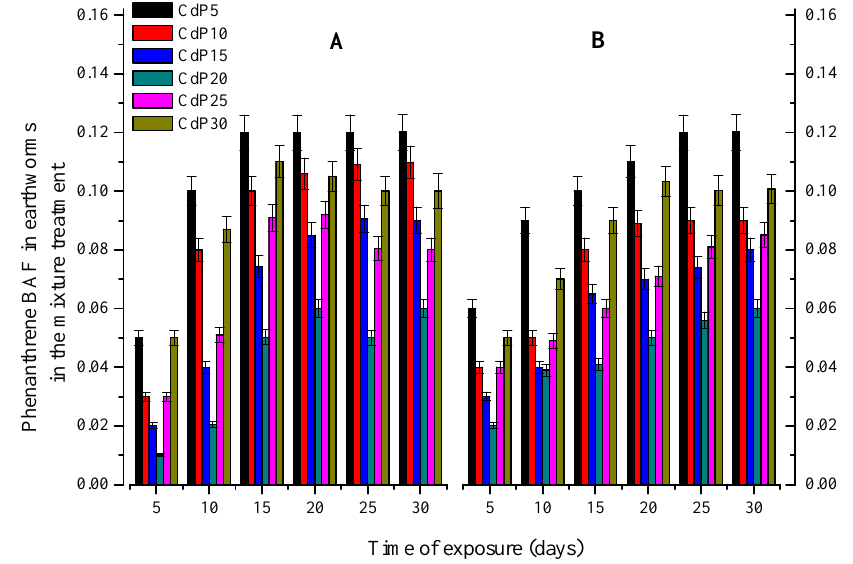
Figure 5. Phenanthrene Bioaccumulation factor (BAF) on E fetida ( A ) and A. caliginosa ( B ) under the mixture treatment of different phenanthrene concentration and Cd LC50 values with the respect to the time. Different presented bands are means of three replicates with standard error (Tukey’s Studentized Range HSD test p = 0.05).